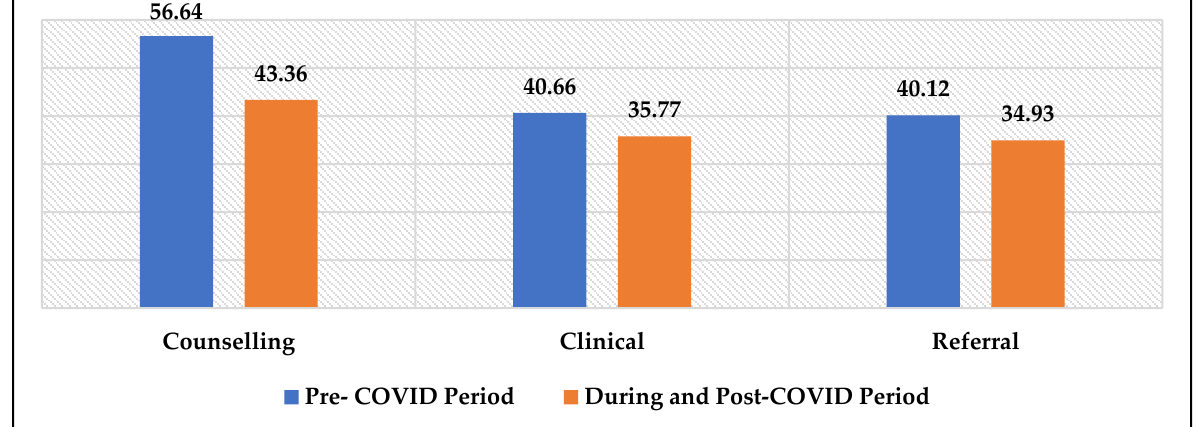
Figure 2. Distribution of counselling, clinical, and referral of beneficiaries for Pre- and during and Post-COVID-19 Period. Note: Pre-COVID-19 phase: 1 June 2018 – 30 April 2020; During and